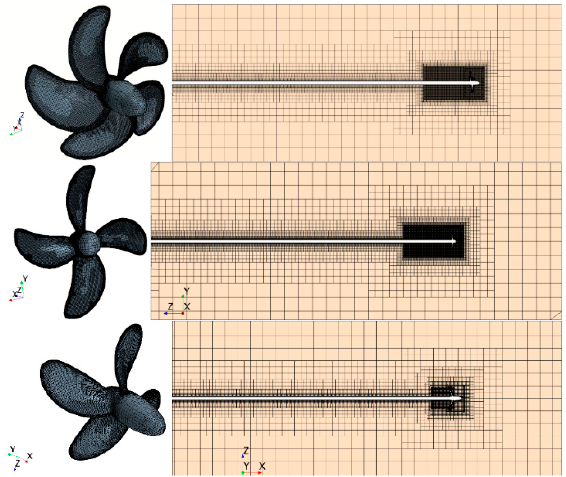
Figure 5. Propeller surface ( left ) and profile view ( right ) cross section of the volume mesh for KP505 ( upper ), KP458 ( middle ) and WB (lower).